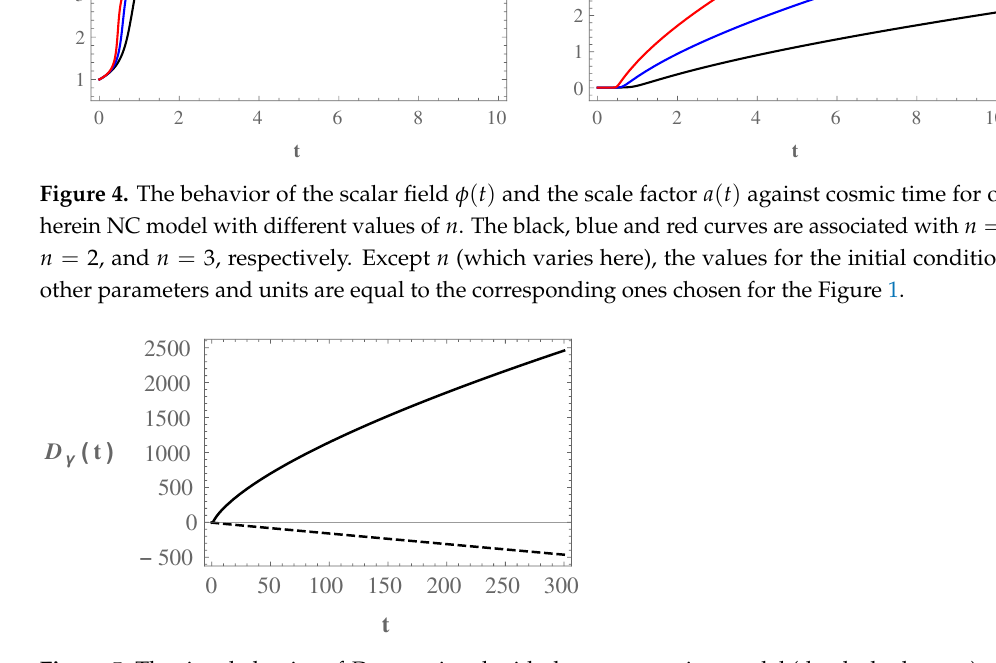
Figure 5. The time behavior of D γ associated with the commutative model (the dashed curve) and the NC model (the solid curve). The values for the initial conditions, parameters of the model, and units are equal to the corresponding ones chosen for the Figure 1.